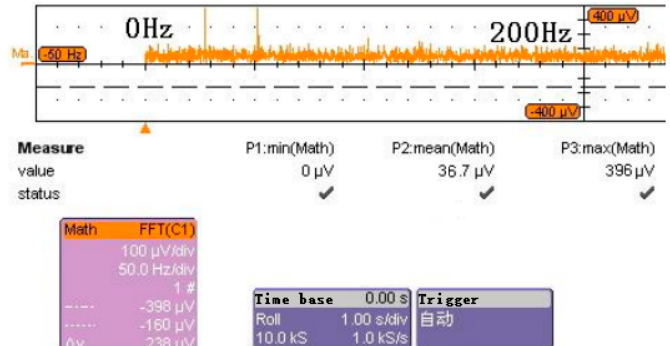
Figure 15. Noise spectrum density of the vacuum microelectronic accelerometer. Micromachines 2018 , 9 , x FOR PEER REVIEW